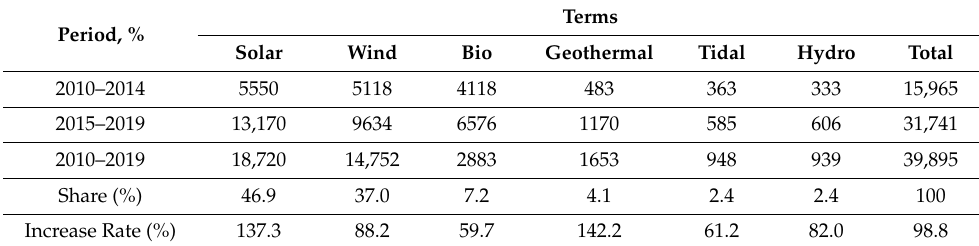
Table 1. Term frequency (TF) by renewable energy type.